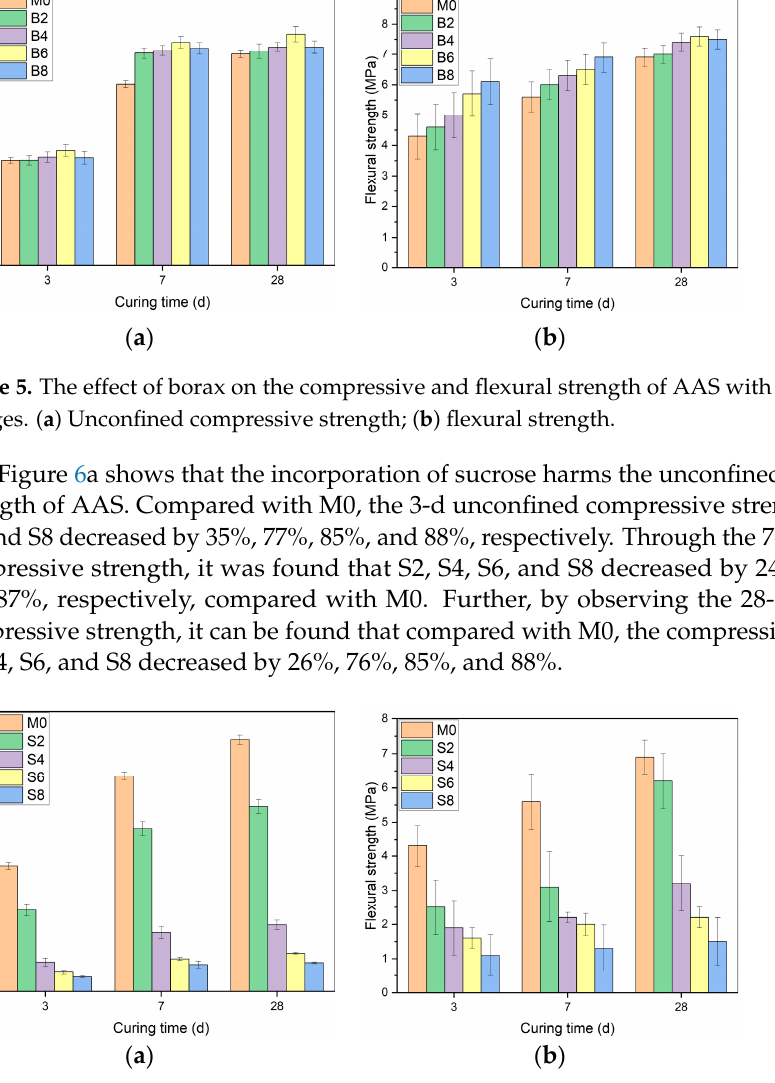
Figure 5. The e ff ect of borax on the compressive and fl exural strength of AAS with di ff erent borax dosages. ( a ) Uncon fi ned compressive strength; ( b ) fl exural strength.